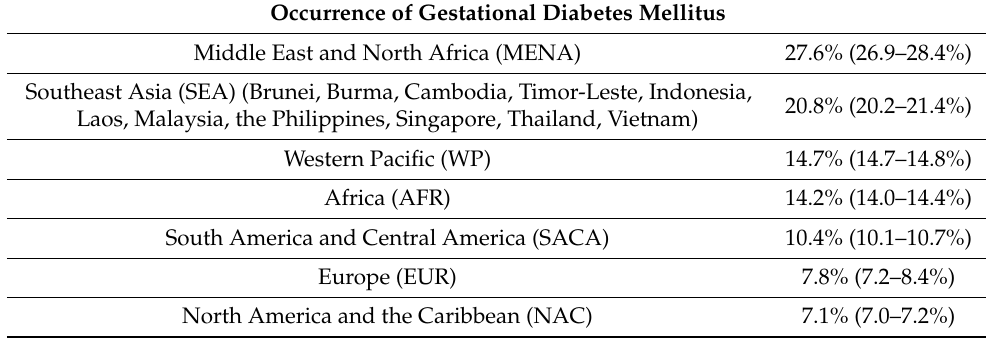
Table 1. The geographical distribution of GDM [3,12]. Occurrence of Gestational Diabetes